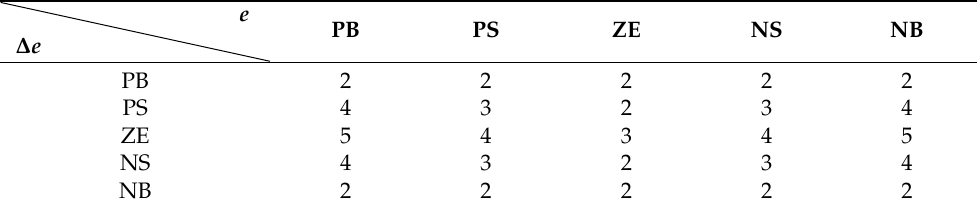
Table 4. Fuzzy rules of α .